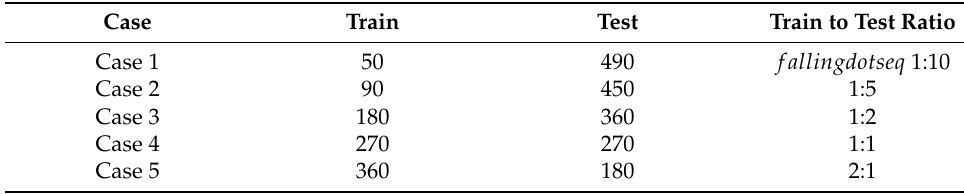
Table 1. Train and test data separation with different ratios.